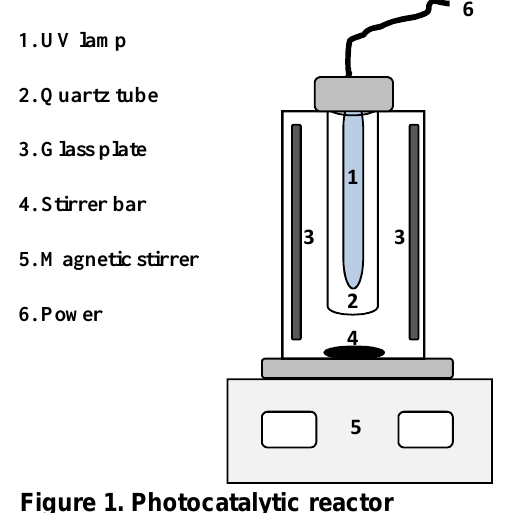
Figure 1. Photocatalytic